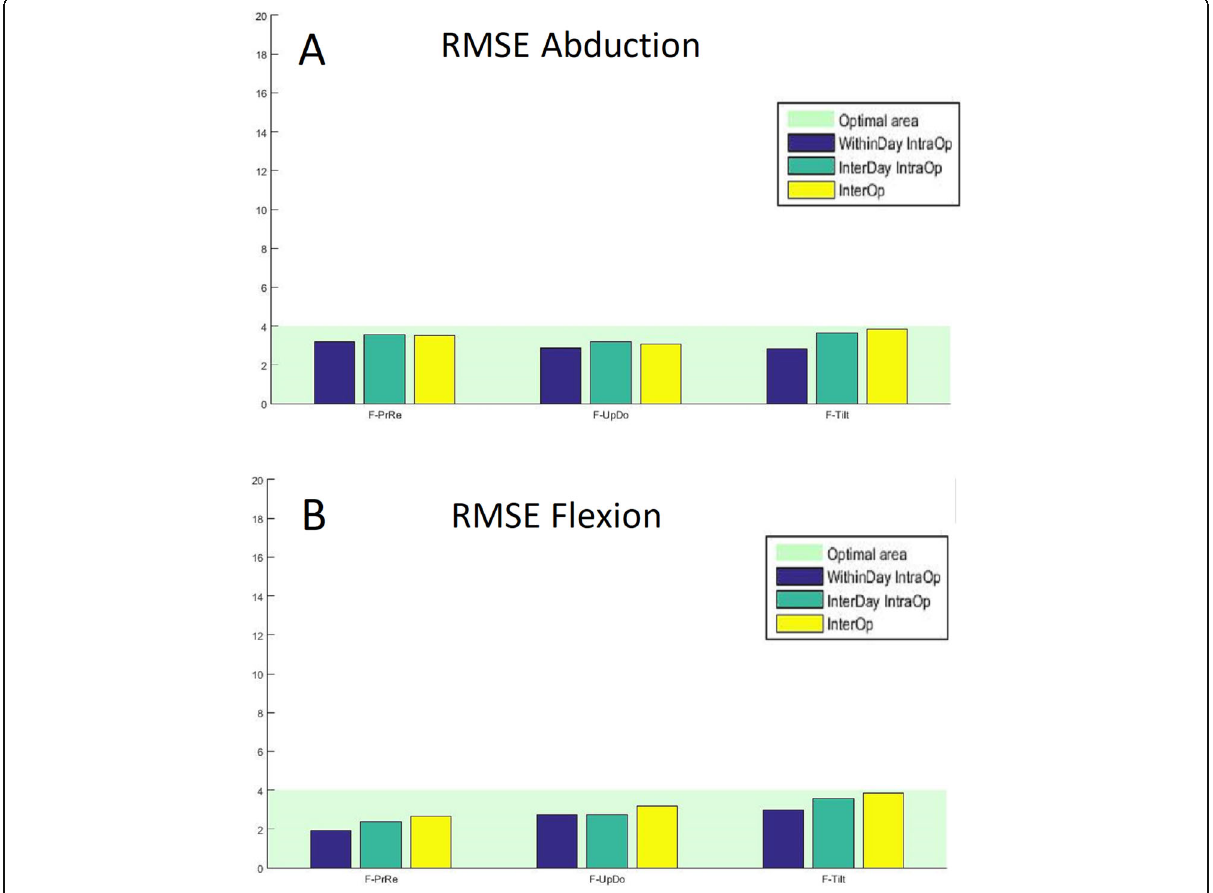
Fig. 5 The calculated RMSE for the three reproducibility analysis ( “ same day ” intra-observer reproducibility [WithinDay IntraOP], “ different day ” intra-observer reproducibility [InterDay IntraOp], and inter-observer reproducibility [InterOp]). The data is presented for all three scapular angles evaluated (upward/downward rotation [S-UpDo], internal/external rotation [S-PrRe] and anterior/posterior tilt [S-Tilt]) during flexion ( a ) and during abduction ( b ). the pale green shaded area represents RMSE values below 4°, which is considered optimal